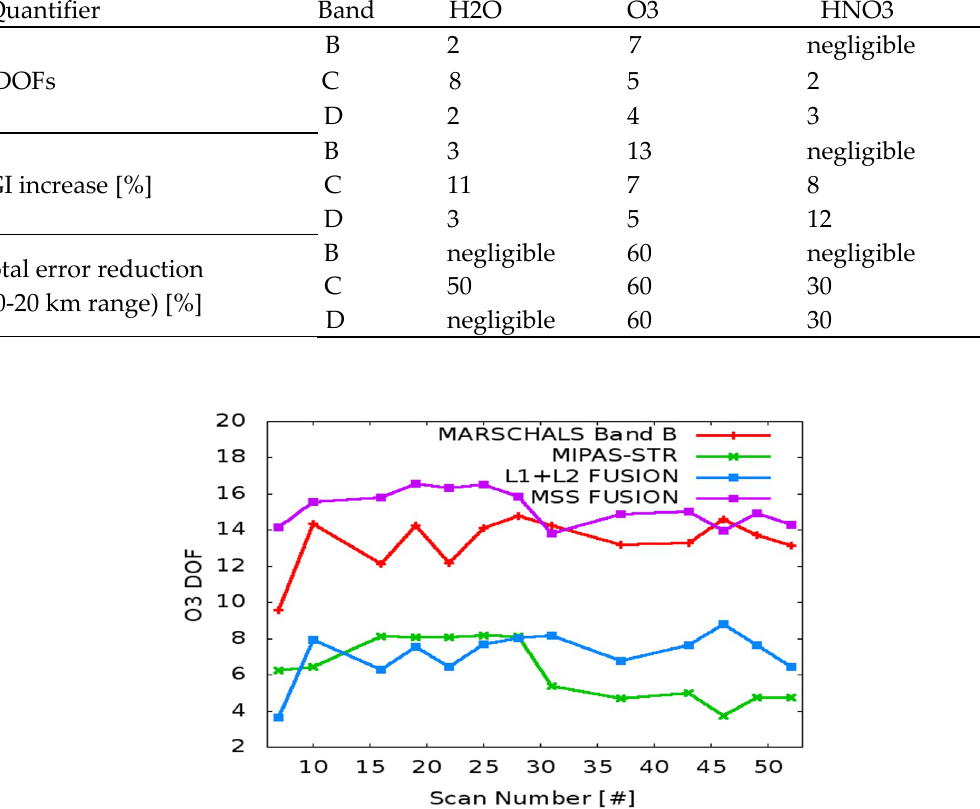
Figure 1: Comparison of number of O 3 DOFs from individual retrievals for MARSCHALS Band B (red), MIPAS-STR (green) with the number of DOFs from synergistic retrieval performed using the L1+L2 (blue) and the MSS (purple)